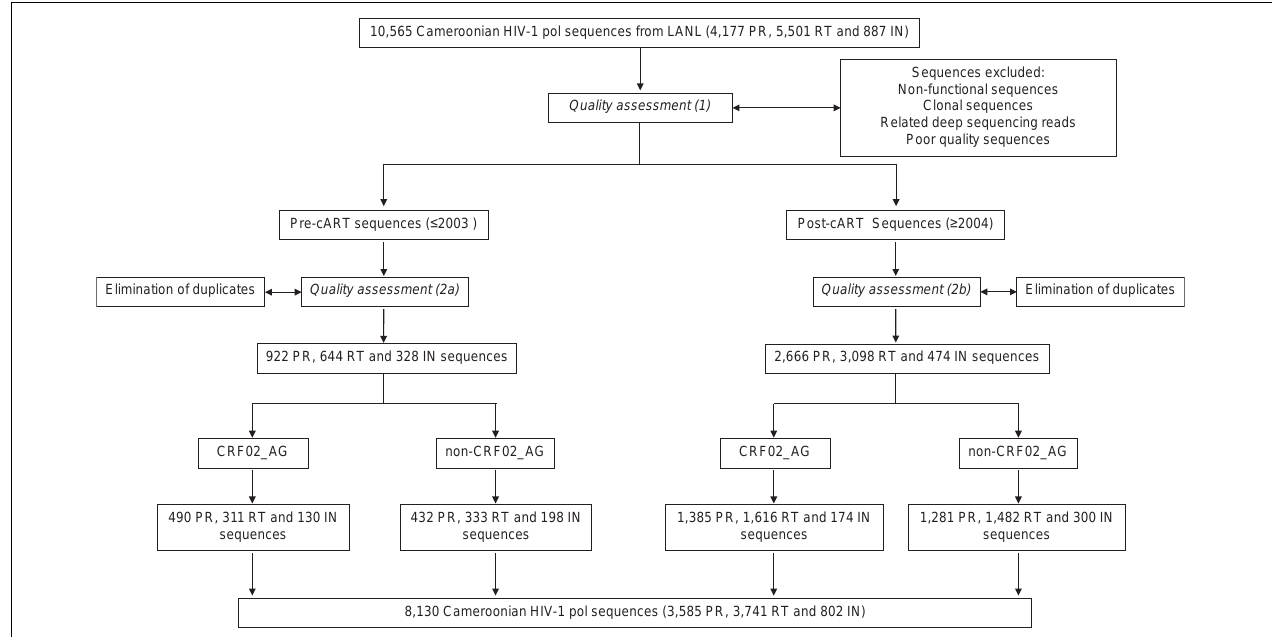
FIGURE 1 | Study flow diagram. Summary of sequence filtering and quality assessment of Cameroonian RT, PR, and IN